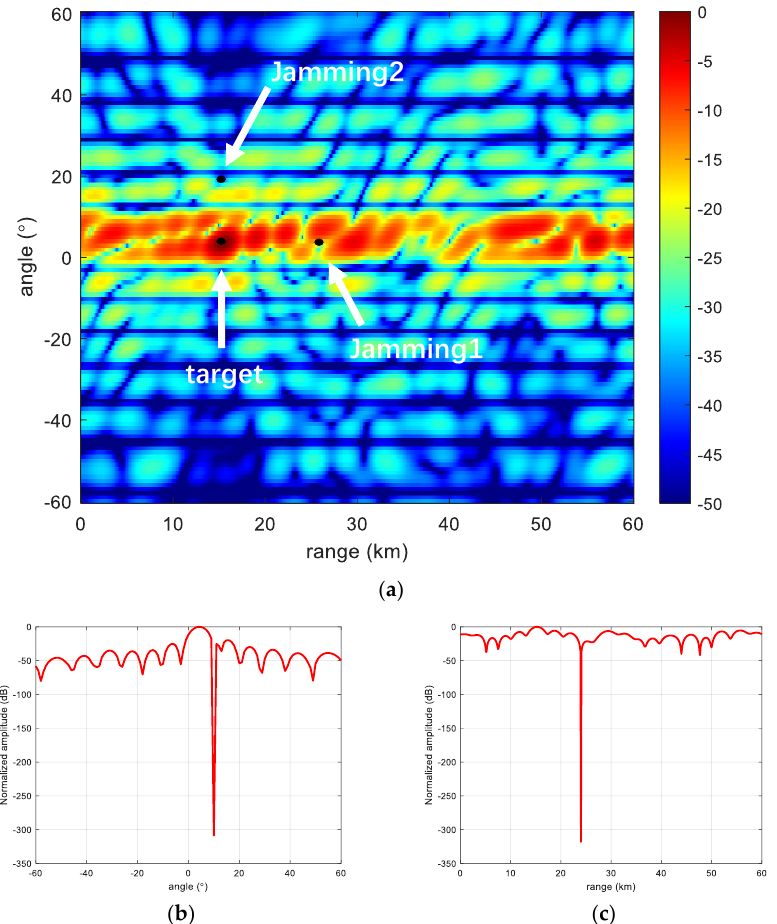
Figure 10. HL-FDA performance. ( a ) HL-FDA; ( b ) Range-dimensional slicing; and ( c ) Angle- dimensional slicing.